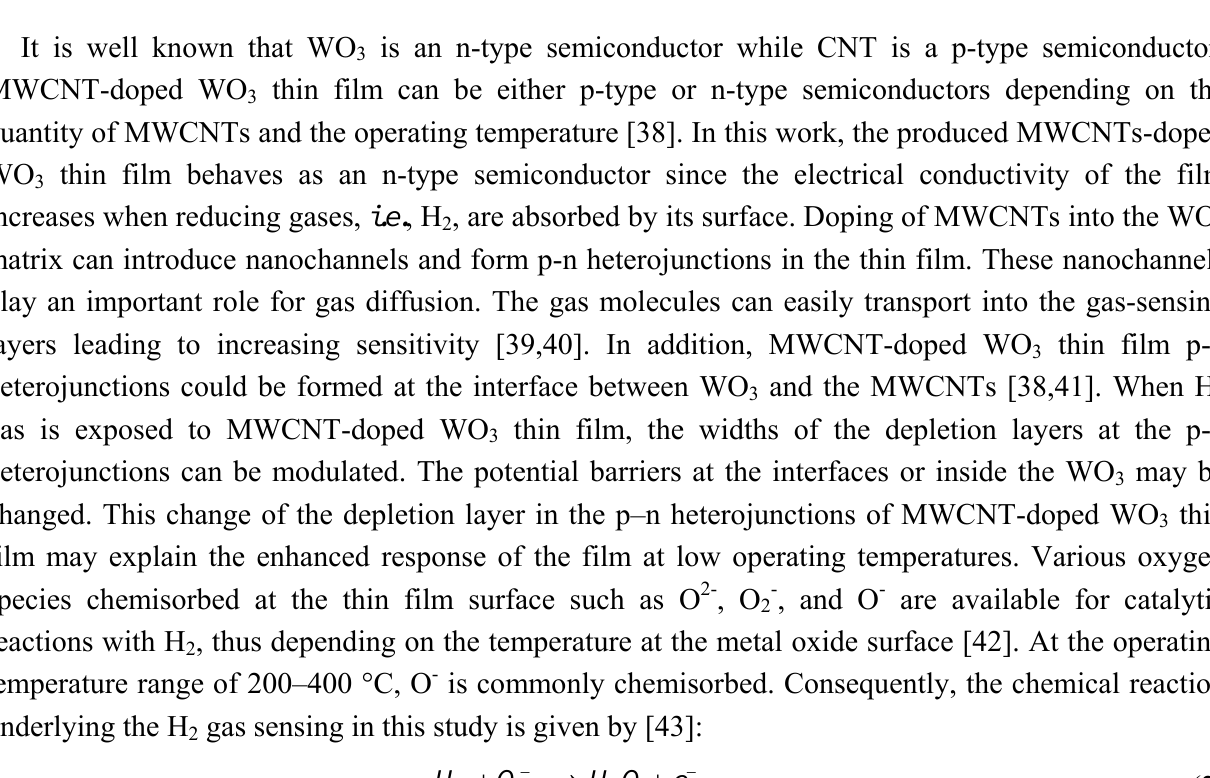
thin film at the operating temperature 3